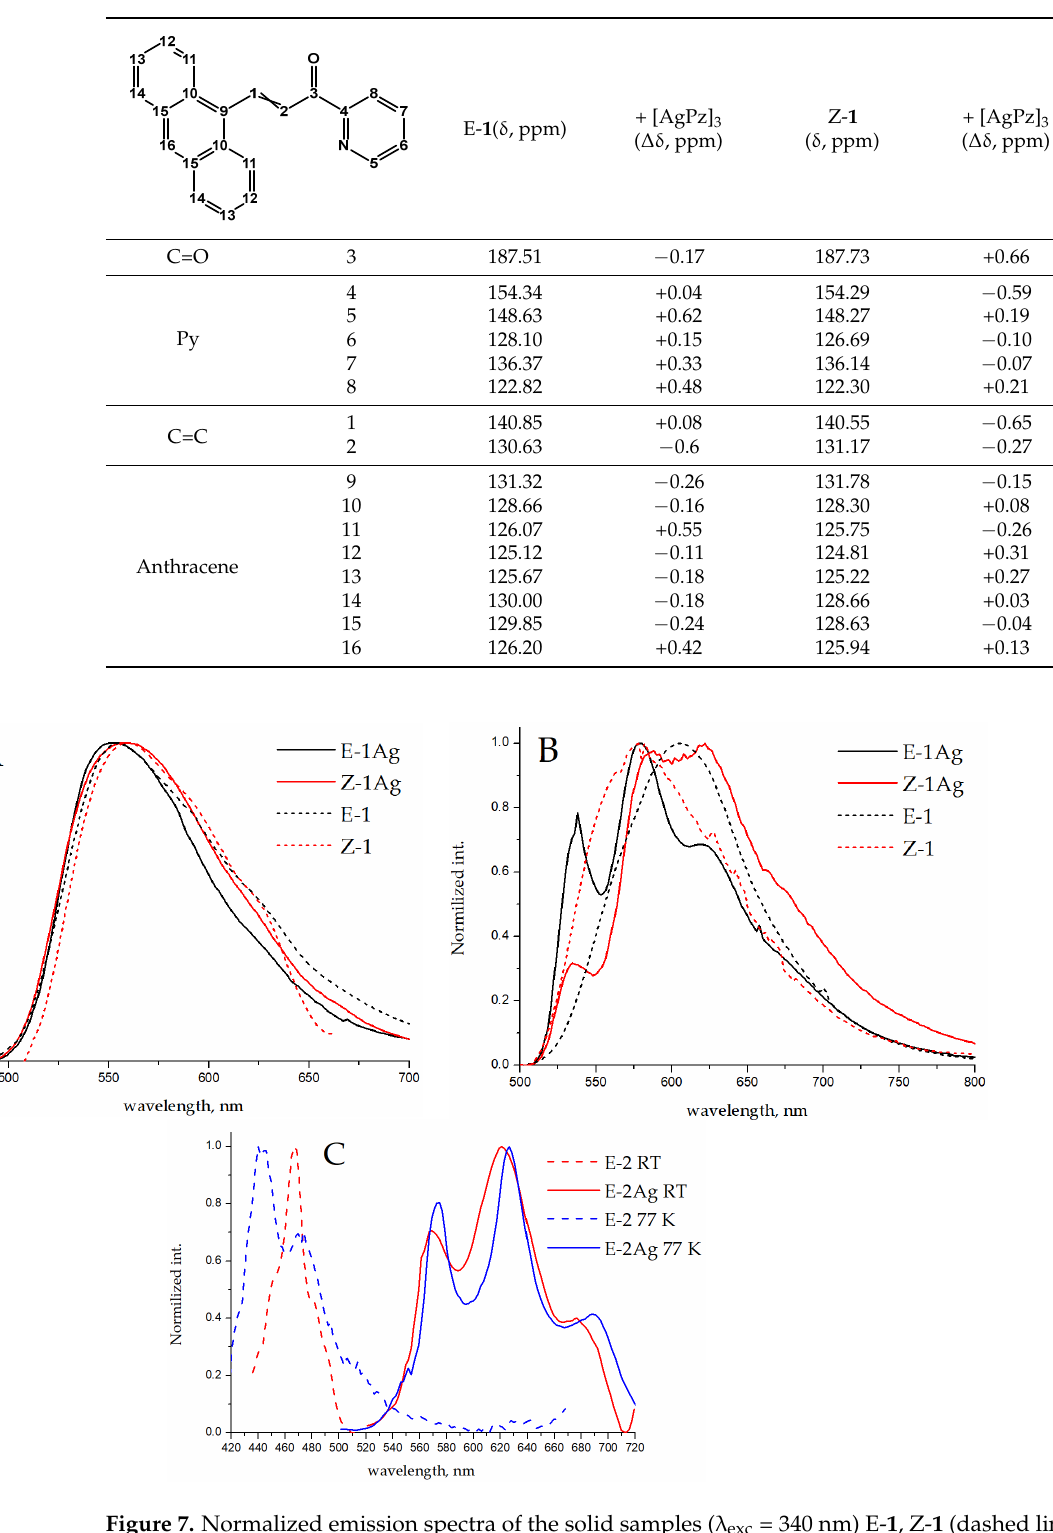
Table 2. 13 C NMR с hemical shifts of E- 1 and Z- 1 in the presence of di ff erent amounts of [AgPz] 3 , CCl 4 /C 6 D 6 ( v / v =9/1), 298 K. Table 2. 13 C NMR chemical shifts of E- 1 and Z- 1 in the presence of different amounts of [AgPz] 3 ,